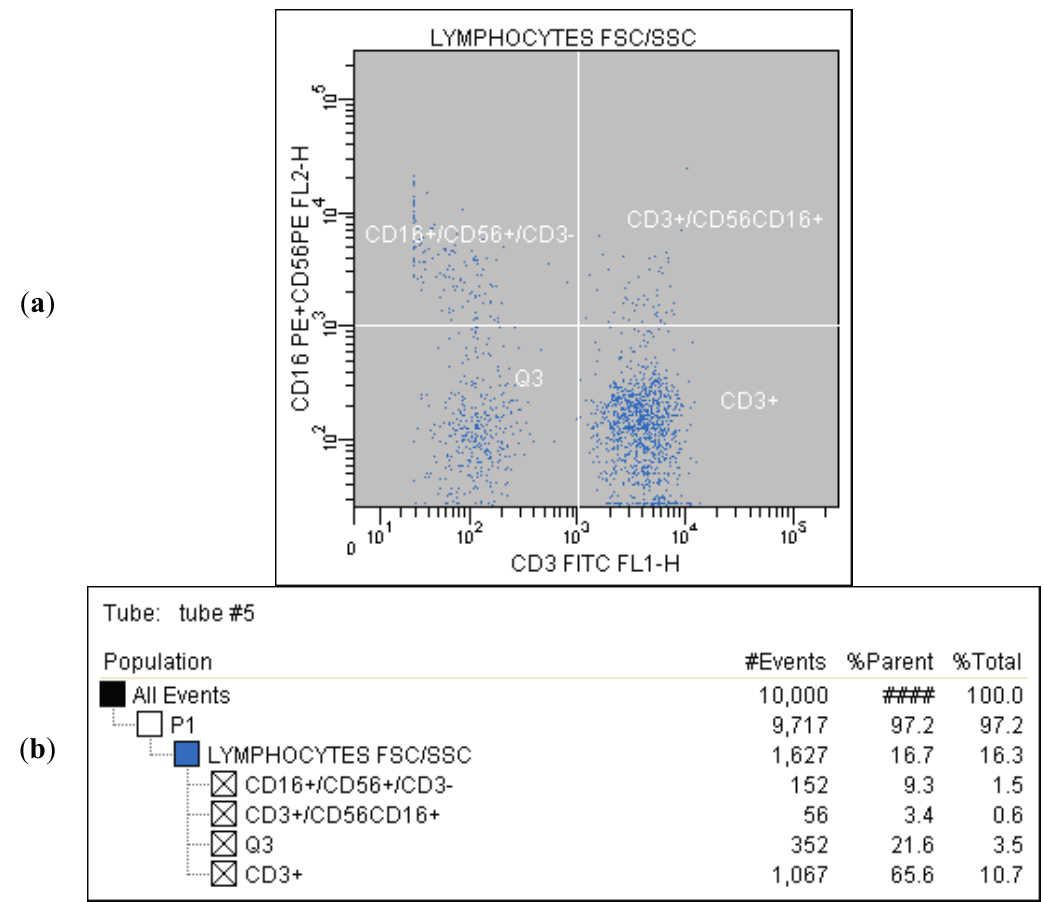
Figure 6. ( a ) Tube No. 5; Dot plot of CD3 FITC/CD16CD56 PE with quadrant markers, differentiating NK cells (CD3 + /CD56CD16 + ) from all lymphocytes; ( b ) Tube No. 5; Gating tree showing gating strategy for FACS analysis as well as parent and total cell percentages within each of the gates for CD56CD16 + and CD3 + .